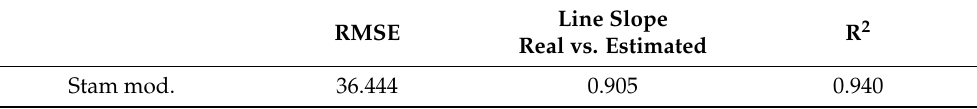
Table 6. Statistical parameters to evaluate the validation of the estimation model of concrete’s electric resistivity. Line Slope RMSE R 2 Real vs. Estimated Stam mod. 36.444 0.905 0.940